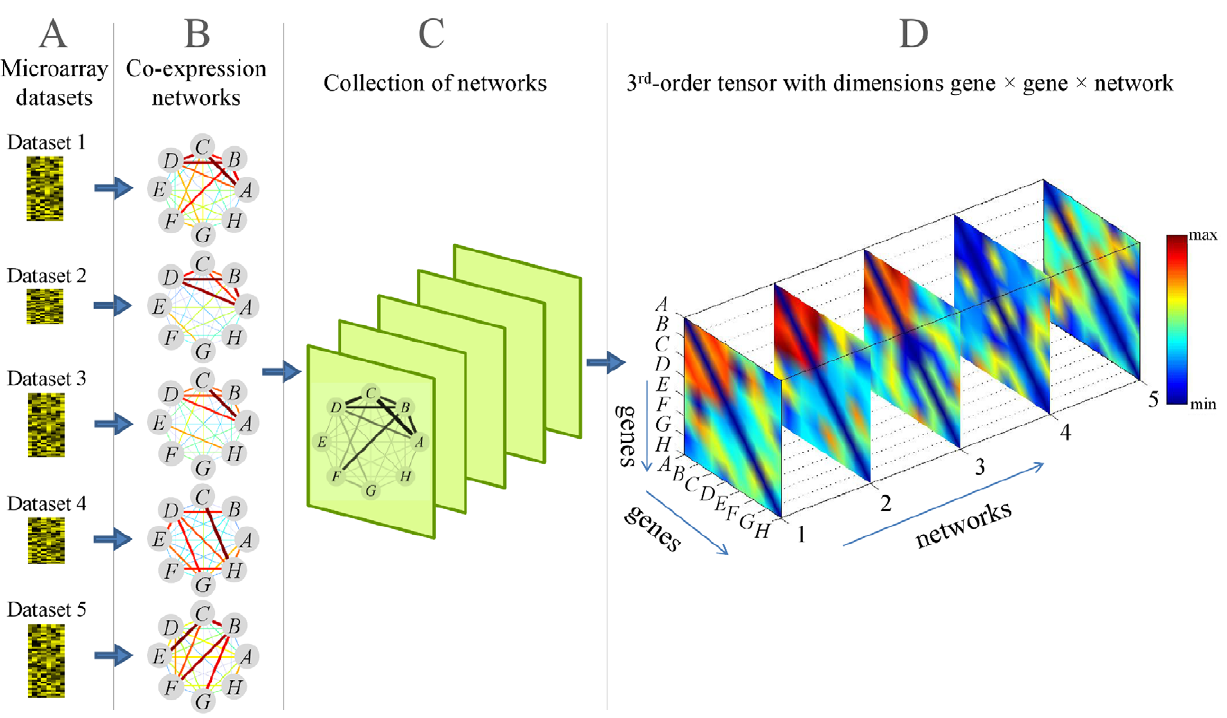
Figure 1. Illustration of the tensor representation for multiple networks and a recurrent heavy subgraph. ( A ) Microarray datasets are modeled as ( B ) a collection of co-expression networks; ( C ) These co-expression networks can be ‘‘stacked’’ together into ( D ) a third-order tensor such that each slice represents the adjacency matrix of one network. The weights of edges in the co-expression networks and their corresponding tensor elements are indicated by the color scale to the right of the figure. In ( D ), after reordering the tensor using the gene and network membership vectors, it becomes clear that the subtensor in the top-left corner of the tensor (formed by genes A , B , C , D in networks 1,2,3 ) corresponds to a recurrent heavy subgraph.